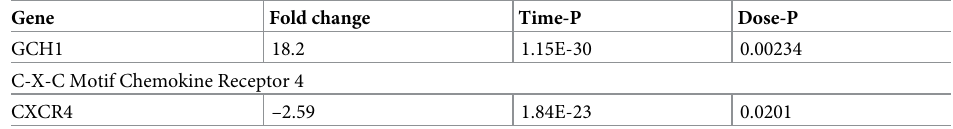
MHCII system. The Ingenuity pathway analysis (Table 2) identified “Antigen Presenta- tion Pathway”, “Th1 and Th2 Activation Pathway”, “Th1 Pathway” and “Th2 Pathway” as among the most statistically significant canonical pathways. The genes in these pathways that were upregulated by IFN- γ administration include many of the MHCII antigen presenting proteins (HLA-DMB, HLA-DMA, HLA-DRA, HLA-DOB, HLA-DQB2, HLA-DRB4, HLA-DPA1, HLA-DQB1, HLA-DQA2, HLA-DPB1) as well as CIITA and RFX5 which